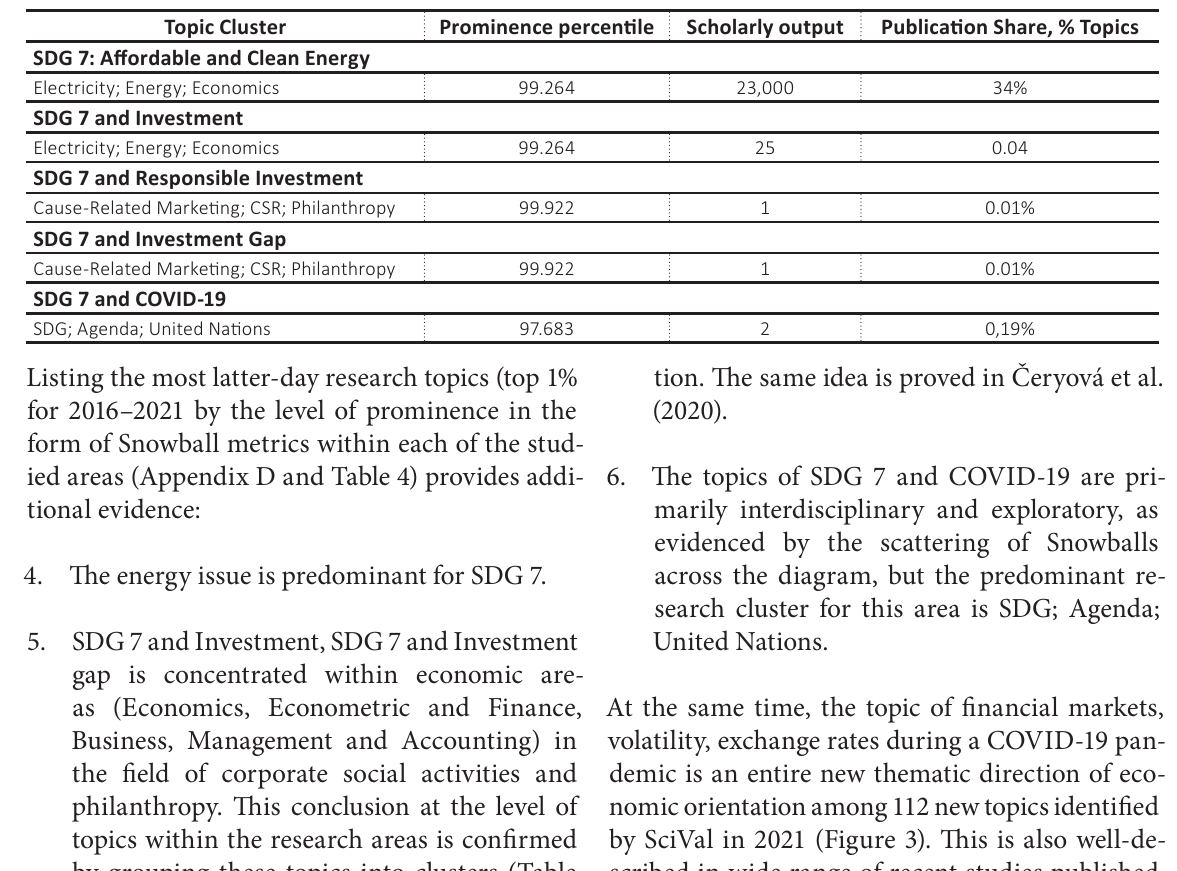
Table 4. Top 1% research area clusters in 2016–2021 by prominence